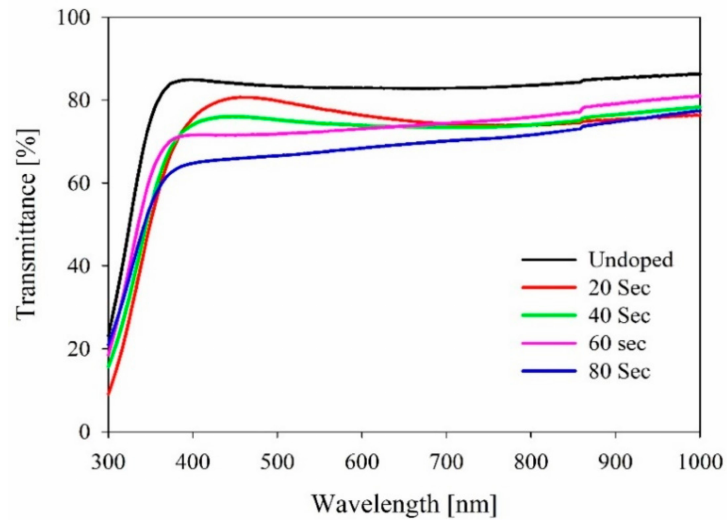
Figure 4. Spectral transmittance of the Cr-doped